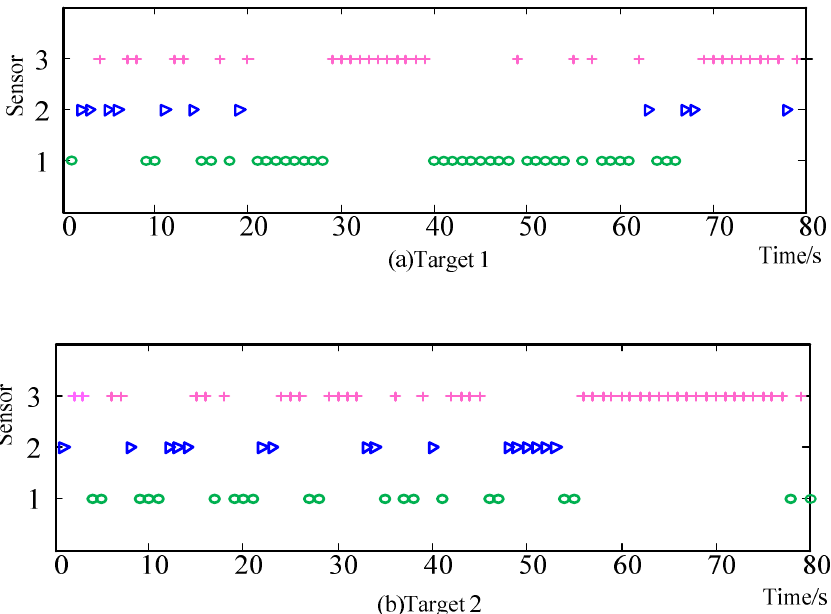
Figure 9 . Sensor selected sequences obtained by BDSP. ( a ) Target 1; ( b ) Target 2.